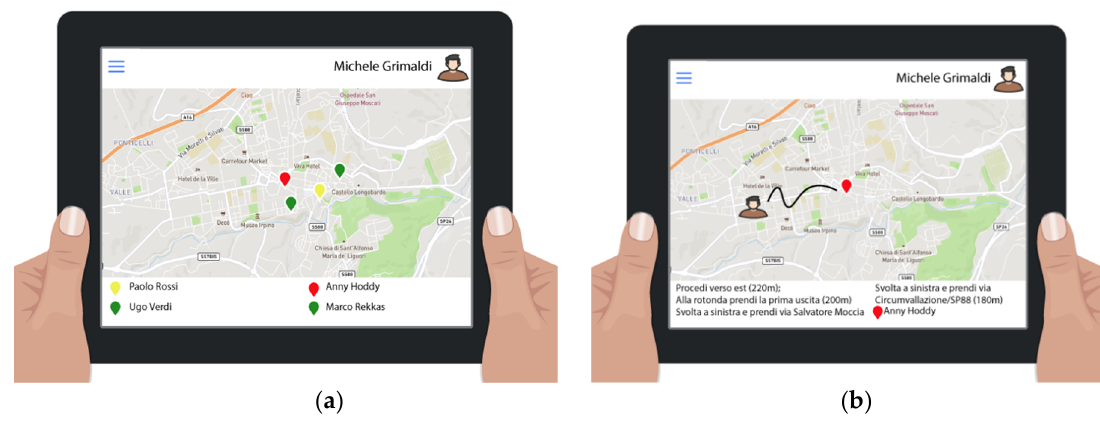
Figure 24. ( a ) Details about users and ( b ) users and operator’s position. Figure 24. (a) Details about users and ( b ) users and operator’s position.